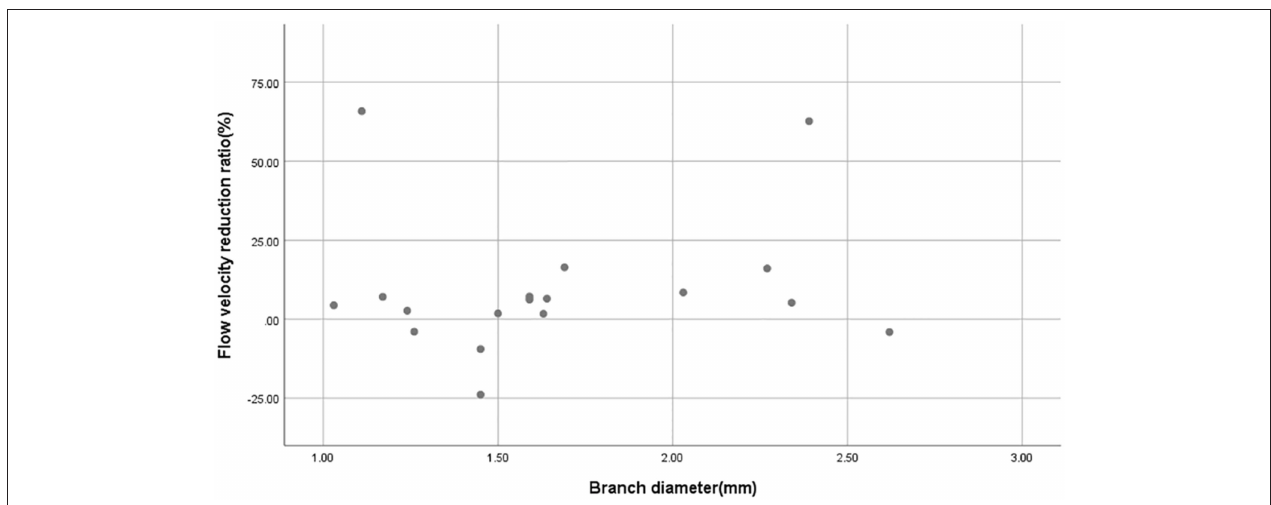
FIGURE 4 | Scatterplot of blood flow reduction ratio distributions derived from different branch diameters. The scatterplot shows that there is no linear relationship between branch diameter and blood flow reduction